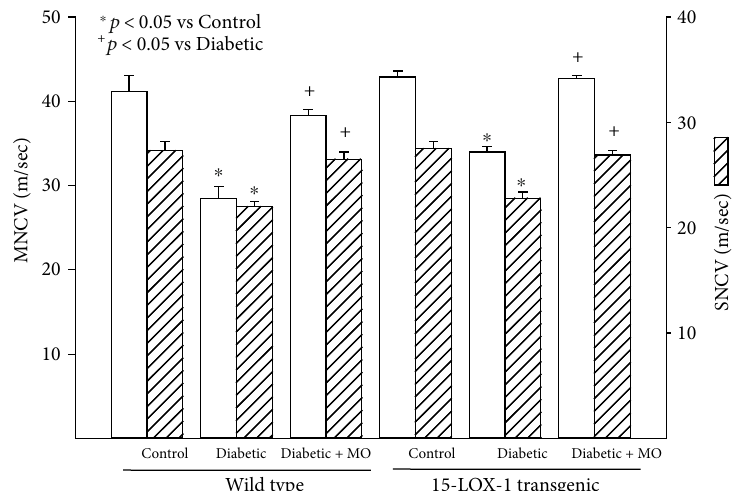
Figure 3: Treatment with menhaden oil of type 2 diabetic wild-type and 15-LOX-1 transgenic mice: e ff ect on motor and sensory nerve conduction velocities. Motor and sensory nerve conduction velocities were examined as described in Section 2. The number of mice in each group was the same as described in Table 1. Data are presented as the mean ± SEM in m/sec. ∗ p < 0 : 05 compared to their respective control mice; + p < 0 : 05 compared to their respective untreated diabetic mice.